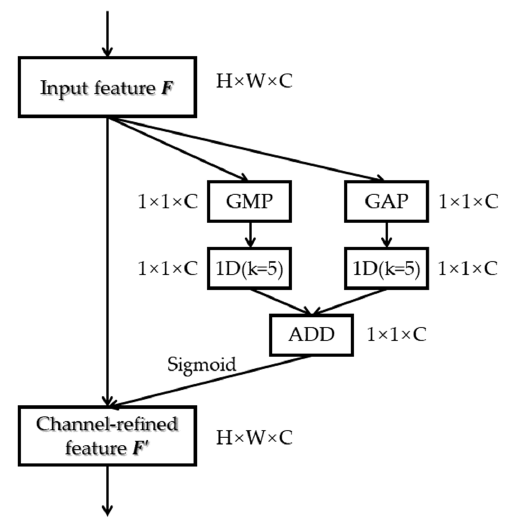
Figure 8. Channel attention module section of